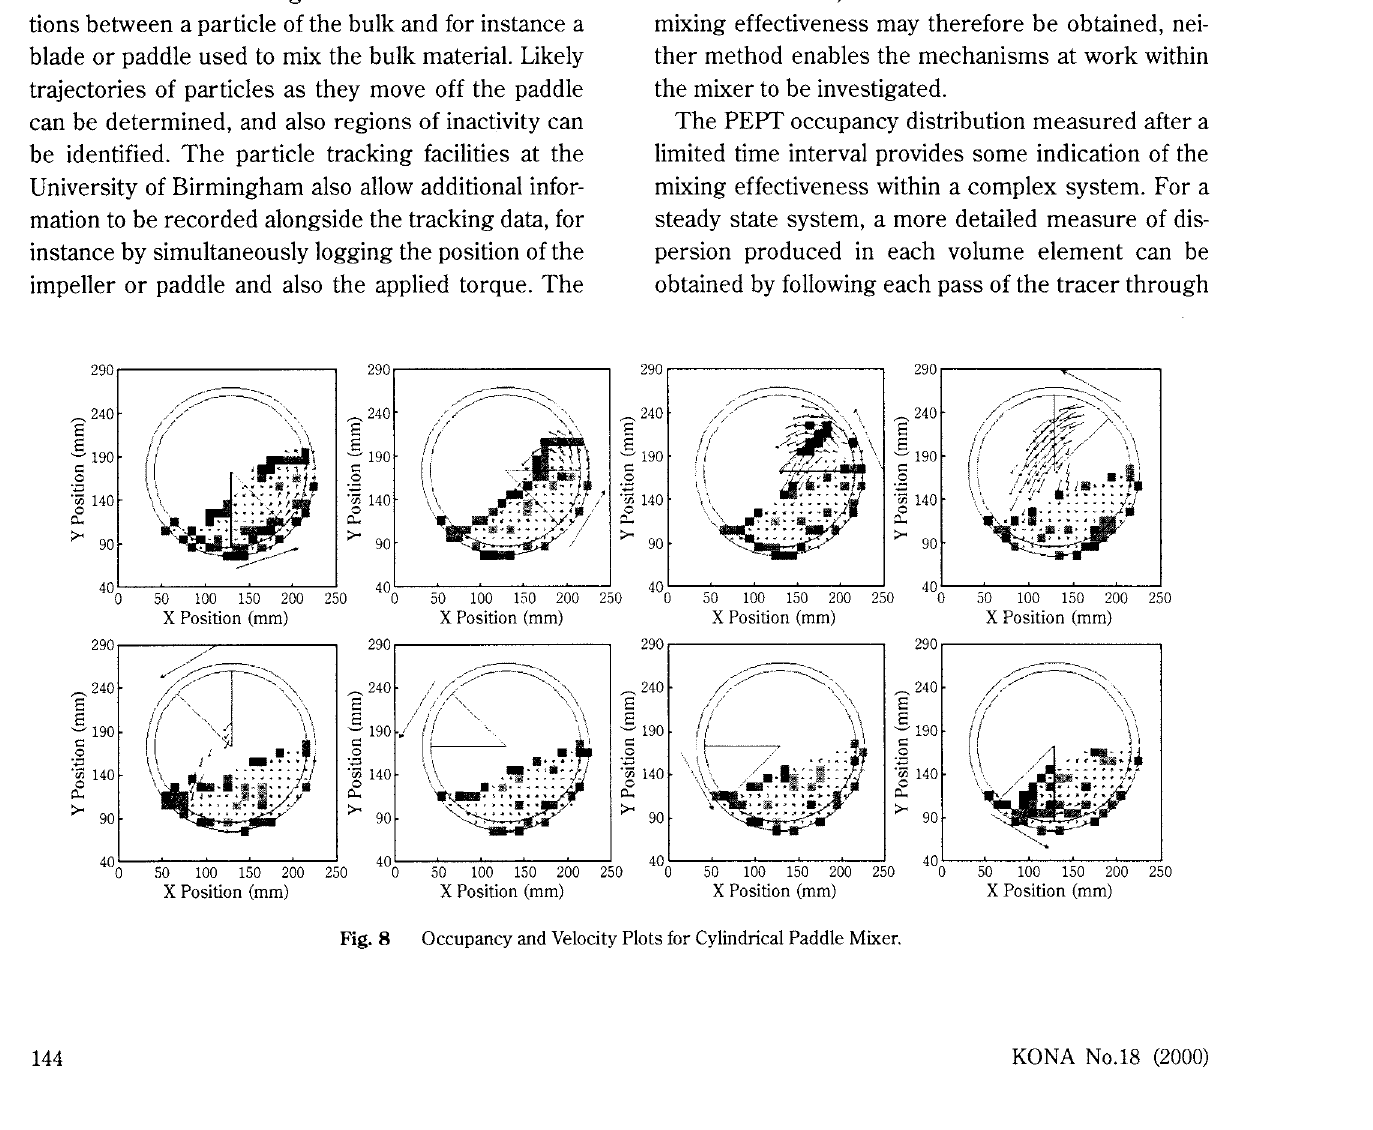
Fig. 8 Occupancy and Velocity Plots for Cylindrical Paddle